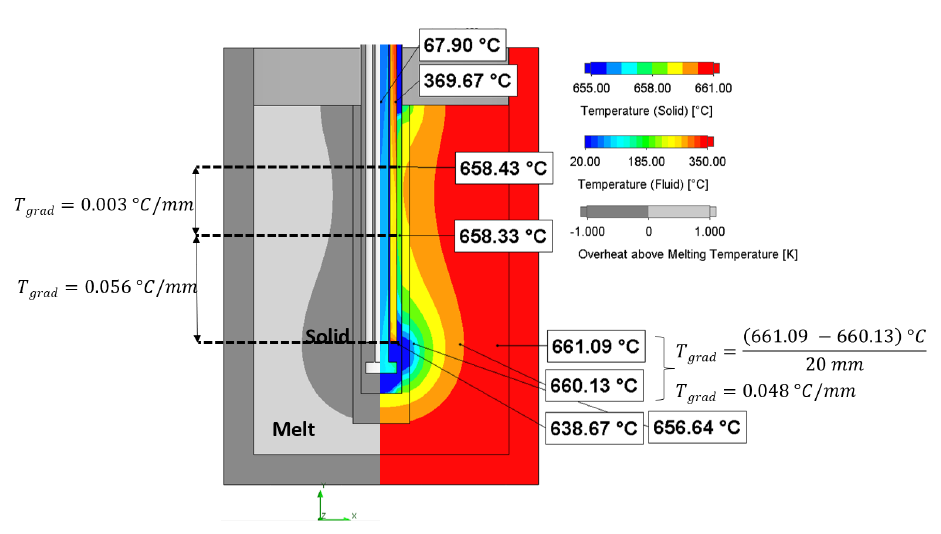
Figure 7. Results obtained by the SolidWorks simulation, showing the crystallized fraction (left side) and the temperature profile of both solid and gas phases (right